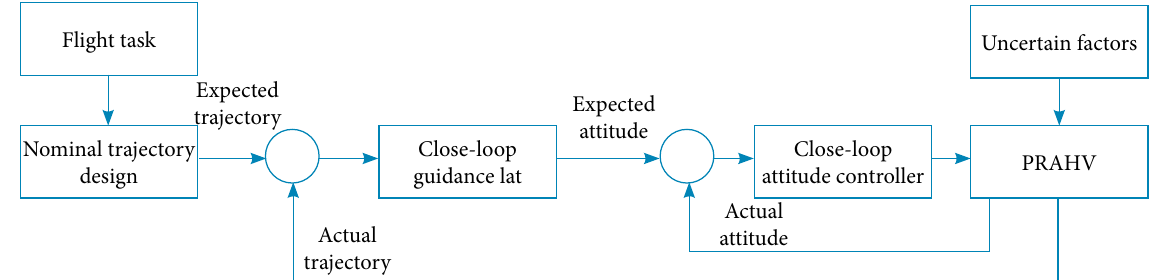
Figure 11. A full research framework of guidance and